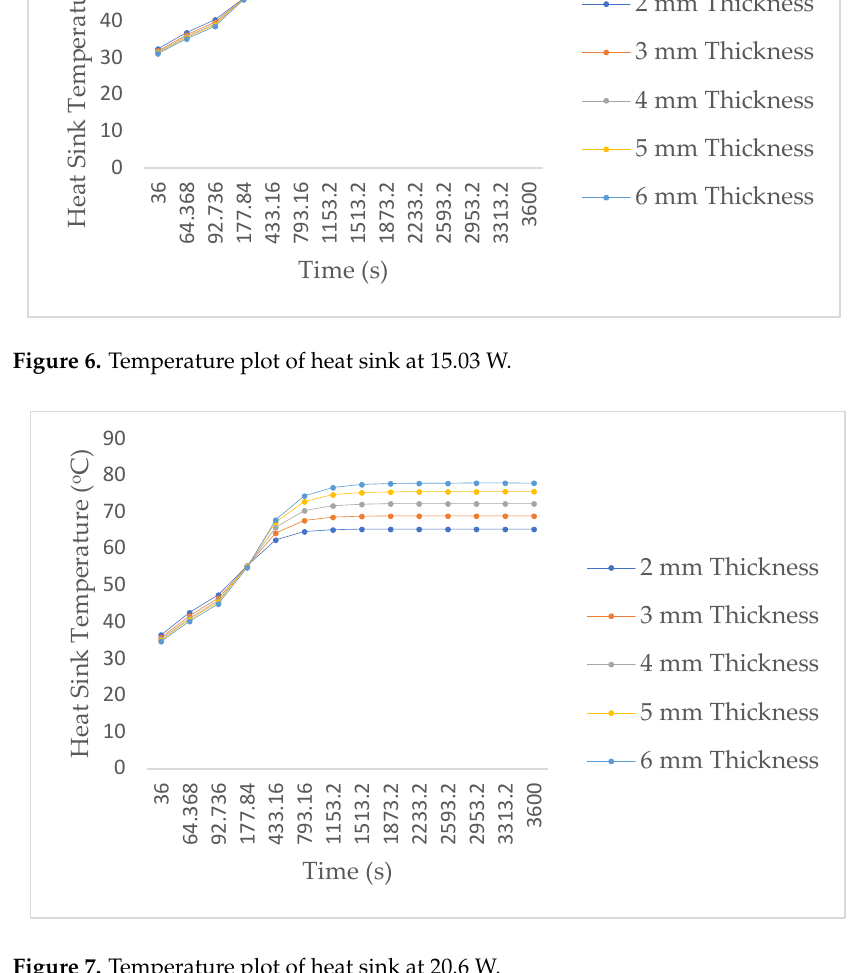
Figure 7. Temperature plot of heat sink at 20.6 W.